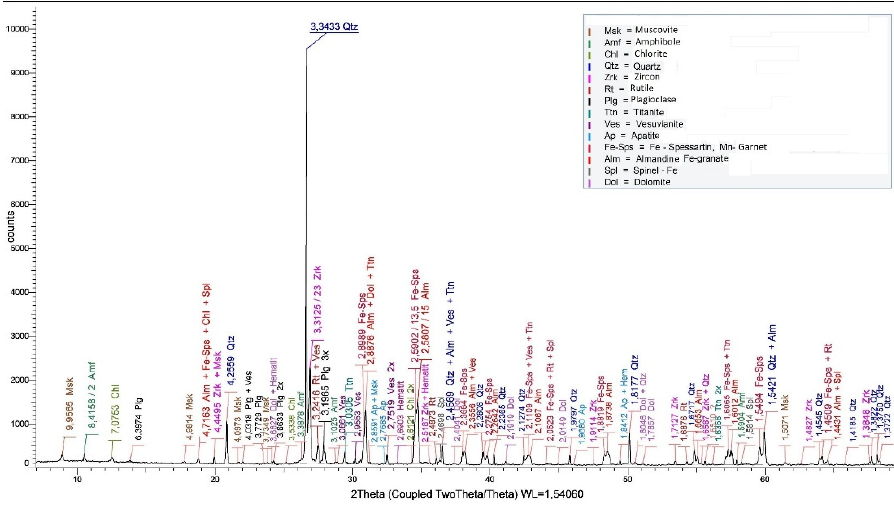
Figure 2. XRD diffractogram of the feed sample. Table 1. Mineralogical composition of the feed sample.